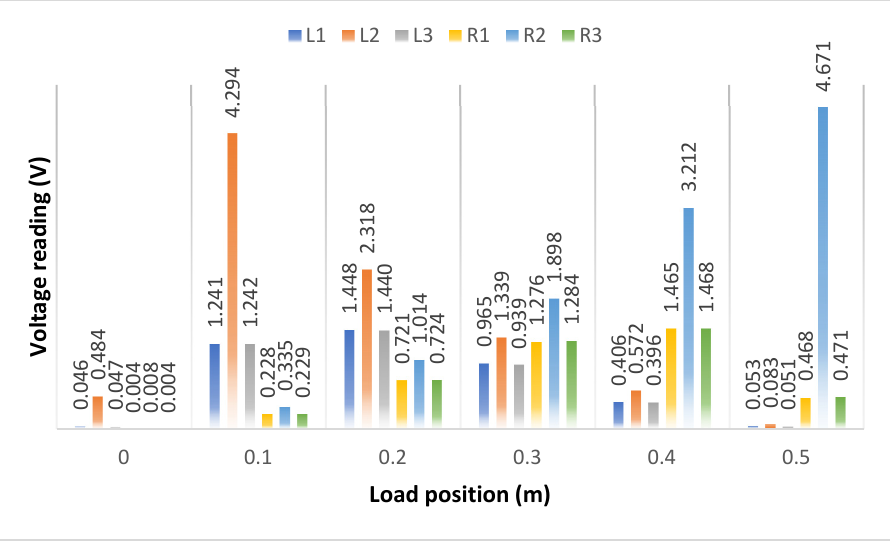
Figure 5. Sensors’ voltage reading in terms of load position for a 40 kg load magnitude moving with 1 m/s speed.